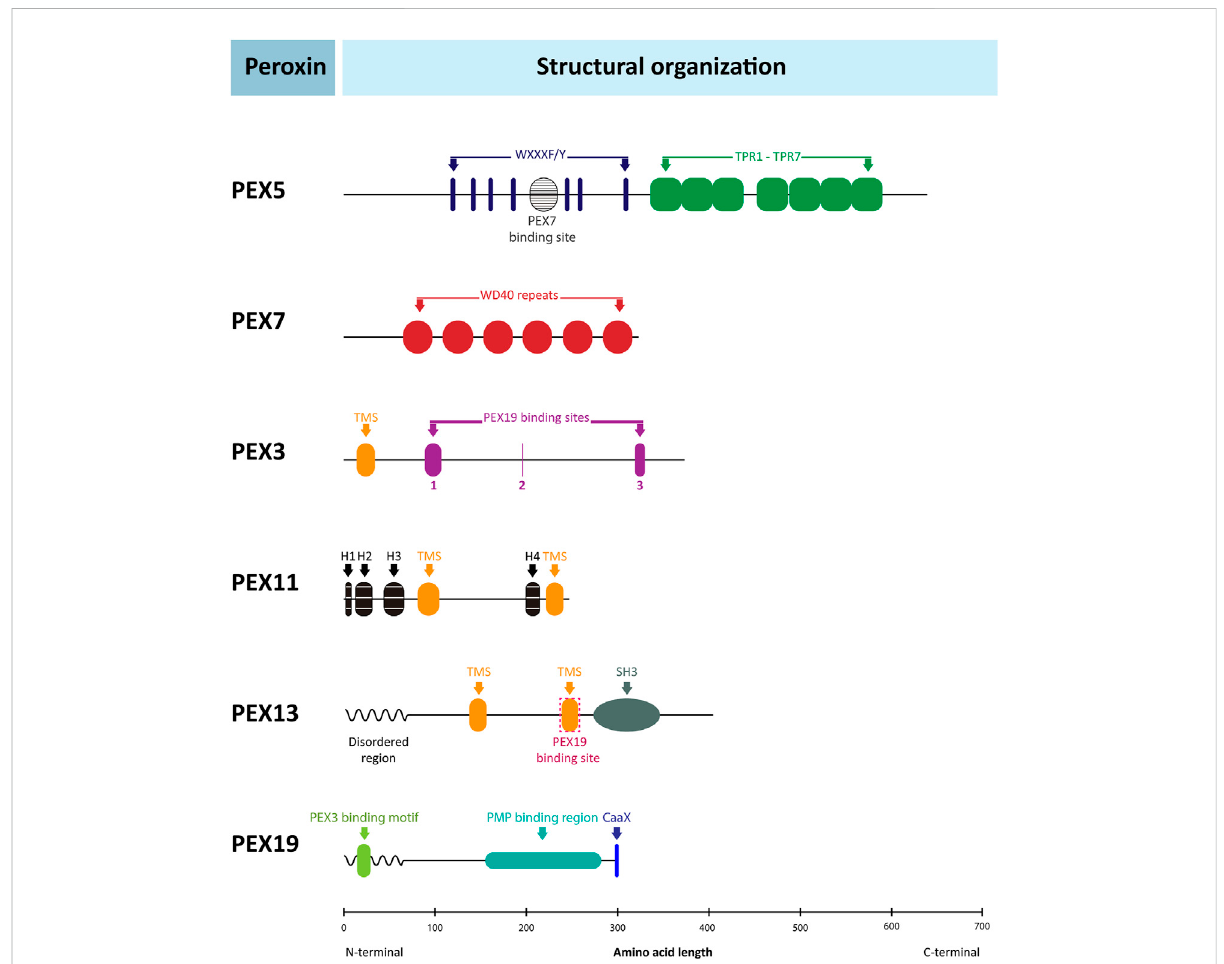
FIGURE 6 Structural organisation of peroxins. Schematic representation of the structure of several human peroxins with the relative position of their functionalmotifs indicatedby coloured boxes andidentitiesspeci fi ed. The organisationof thecorresponding peroxins from yeasts and plants isvery similar, but many important differences are found in the peroxins of Euglenozoa as discussed in the text and shown in detail in the sequence alignmentsinFigure7andSupplementaryFiguresS6 – S12.ThehumanperoxinsIDsare:PEX5(P50542);PEX7(O00628);PEX3(P56589);PEX11 α (O75192); PEX13 (Q92968); PEX19 (P40855). TPR: tetratricopeptide repeats; TMS: transmembrane segment; H1-3: amphiphilic